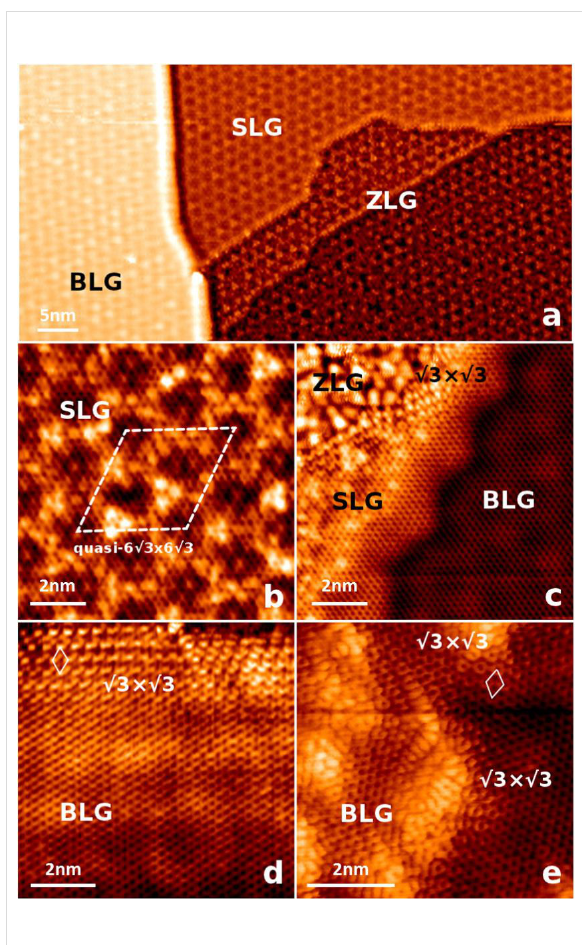
Figure 1: Constant-current STM images taken over an incomplete graphene layer grown on the 6H-SiC(0001) (color online). (a) 67 × 33 nm 2 , V bias = − 1.5 V, I = 0.15 nA; overview of an area containing the buffer layer (ZLG) and single- and bi-layer graphene (SLG and BLG). (b) 10 × 10 nm 2 , V bias = 0.5 V, I = 0.18 nA; subsur- face features bonds of the buffer layer visible through a sheet of graphene, the characteristic